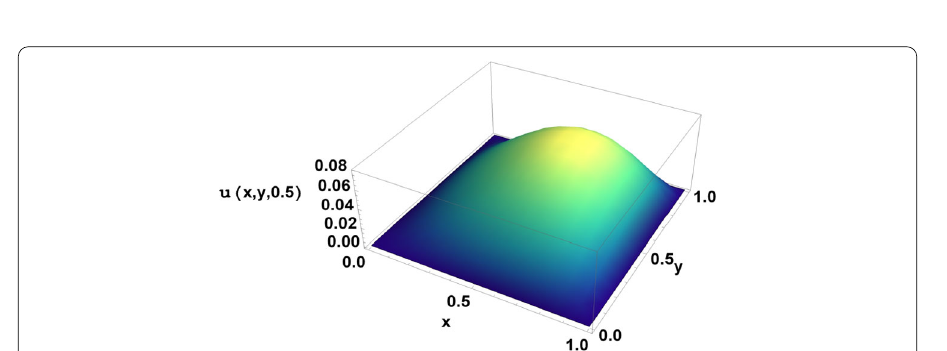
Figure 11 The numerical and exact results at y = z = 0.5